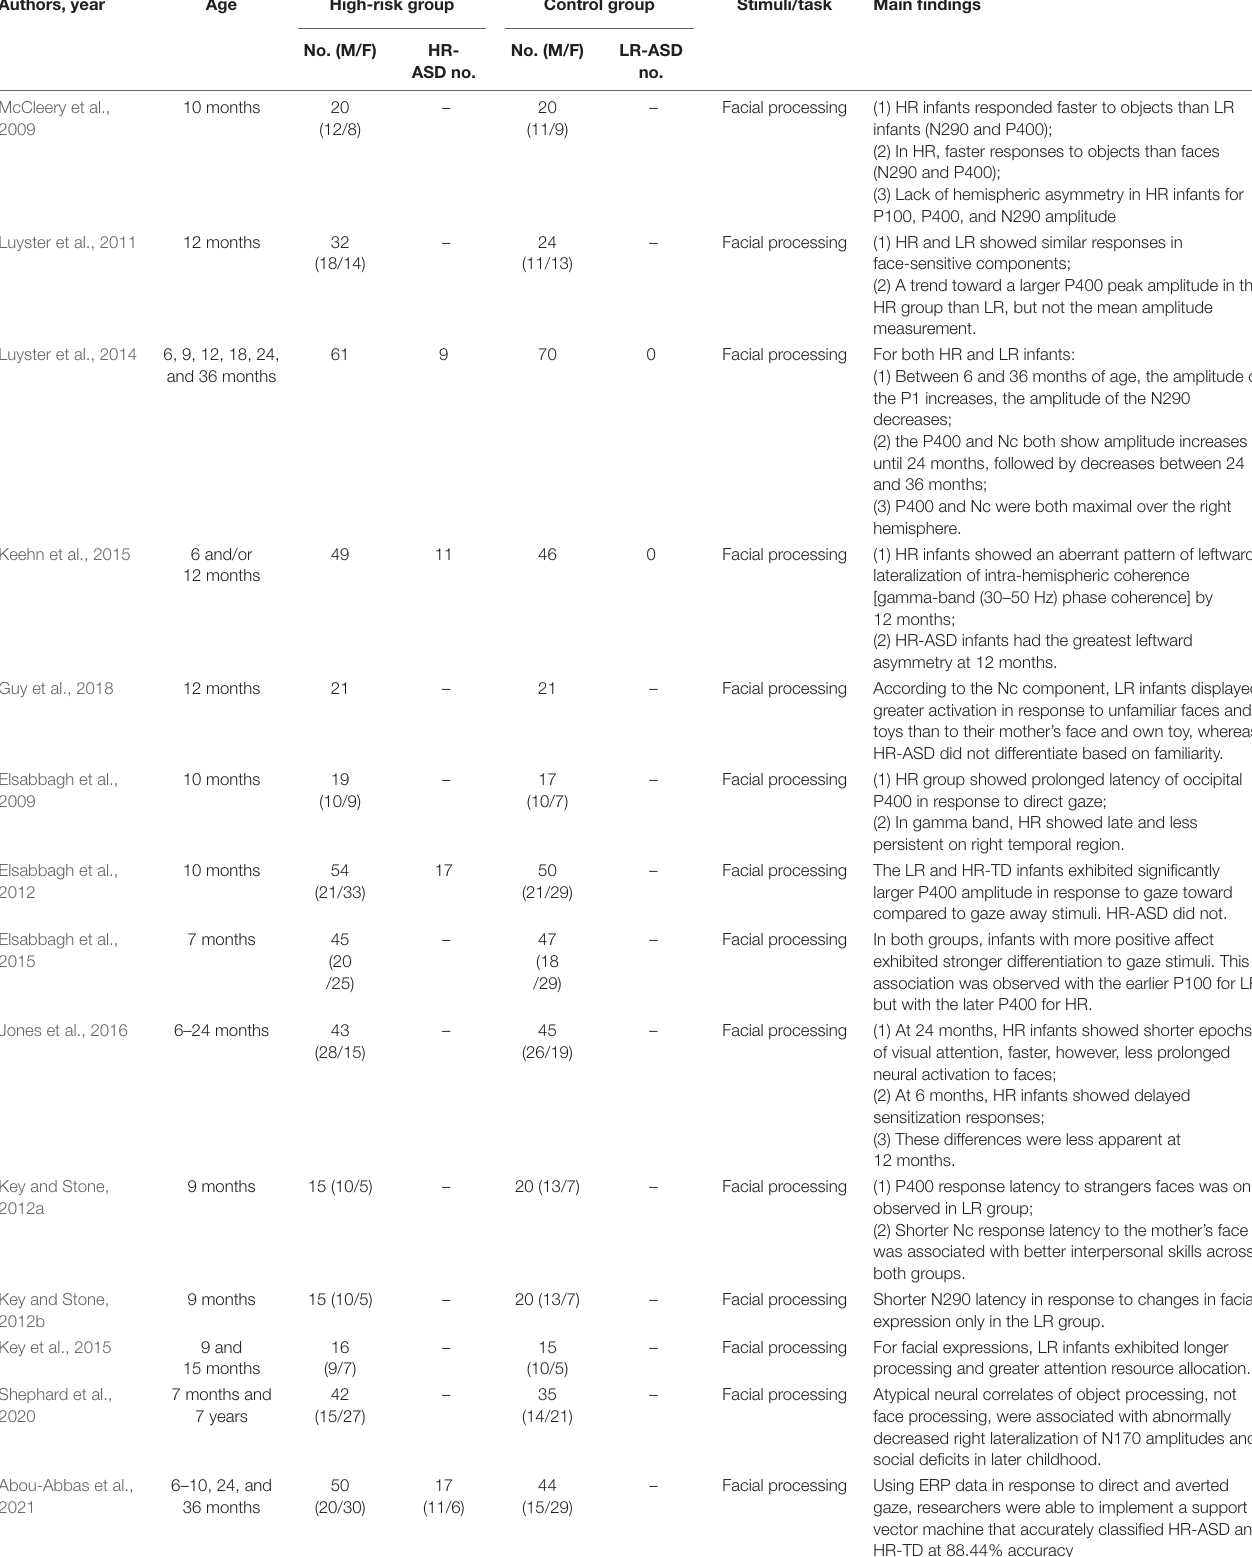
TABLE 2 | Electroencephalogram (EEG) studies on early screening of autism spectrum disorders.